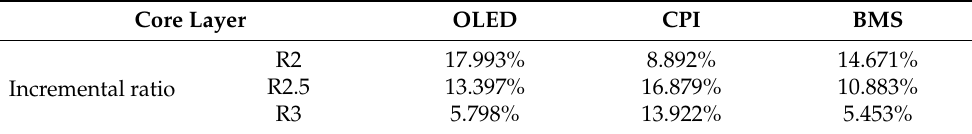
Table 6. Maximum stress increment ratio of the core